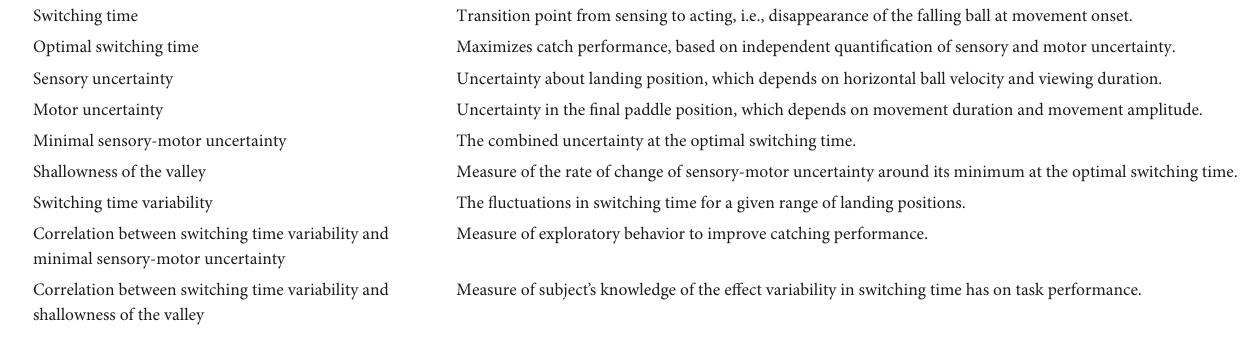
Switching time Optimal switching time Sensory uncertainty Motor uncertainty Minimal sensory-motor uncertainty Shallowness of the valley